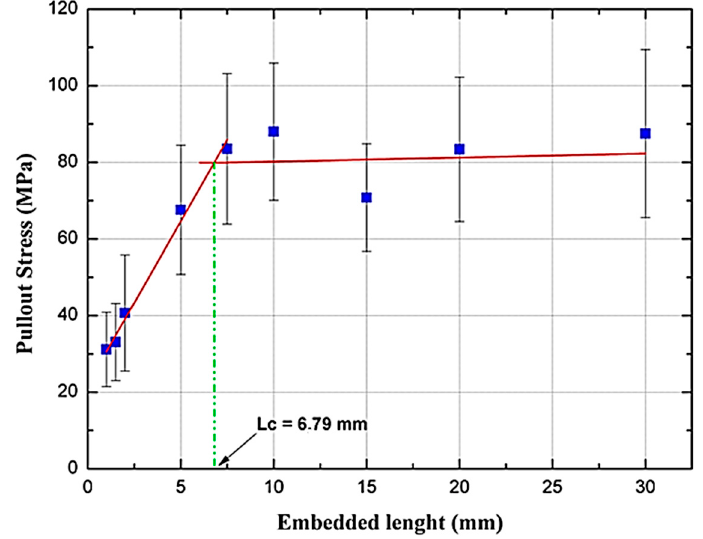
Figure 5. Pullout test of the different depths of carnauba fiber embedding in the epoxy resin.